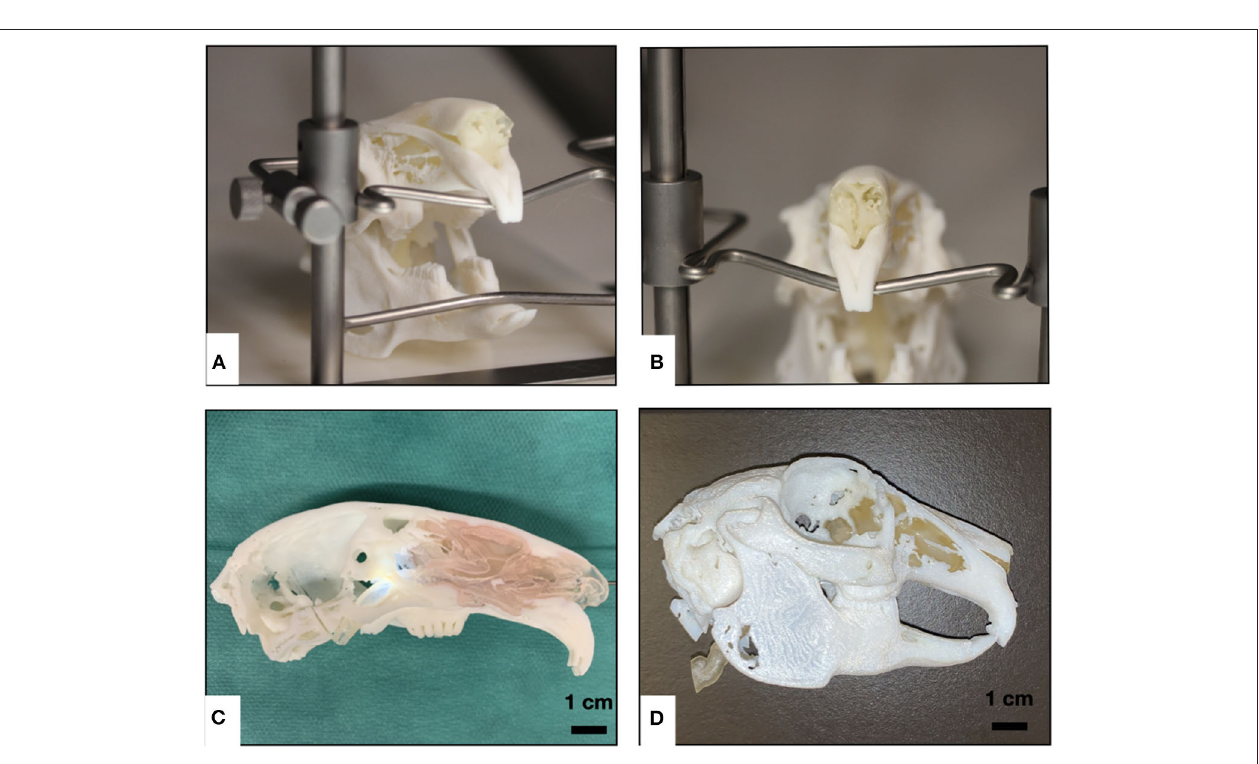
FIGURE 6 | Overview of different multi-material 3D printed rabbit airway models using polyjet technology. (A) Intact µ CT-based model rostro-lateral view, (B) µ CT-based model rostral view of the nasal soft tissues, (C) µ CT-based sagittal cross-sectional model view with pink-colored soft tissue, and (D) intact CBCT-based model lateral